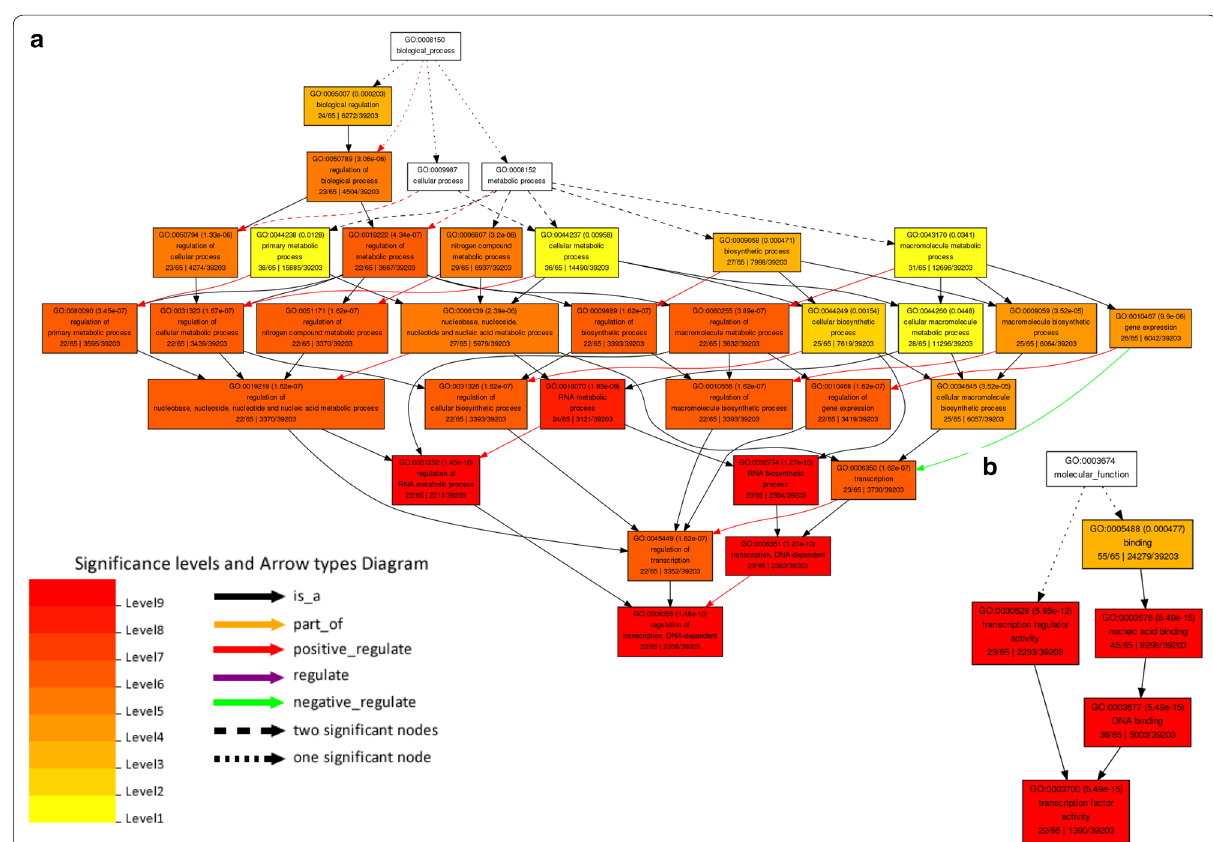
Fig. 4 Significantly enriched pathways for the differentially expressed conserved miRNA targets in Bt‑expressing plants. a Differentially regulated pathways for biological processes; and b for molecular function (FDR < 0.05) analysed by agriGO online